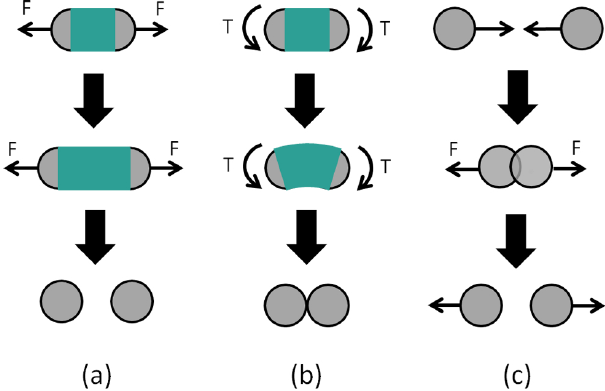
Fig. 1. The particles connected with a beam can (a) stretch when a force F is applied and (b) bend when a torque T is applied. Parti- cles that overlap, i.e. come into contact (c) will experience repulsive forces. The amount of stretching and bending required for beam breaking is highly exaggerated as is the amount of particle overlap in the